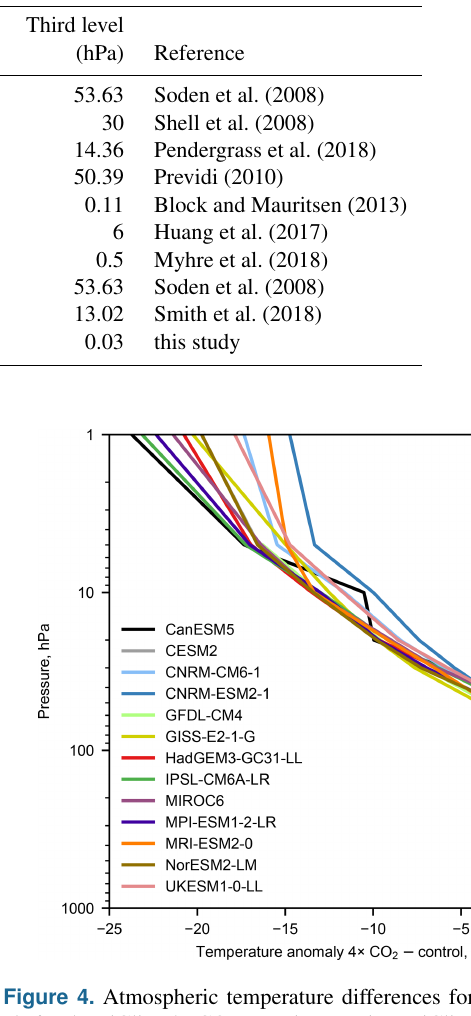
Table 1. Radiative kernels considered in this study.